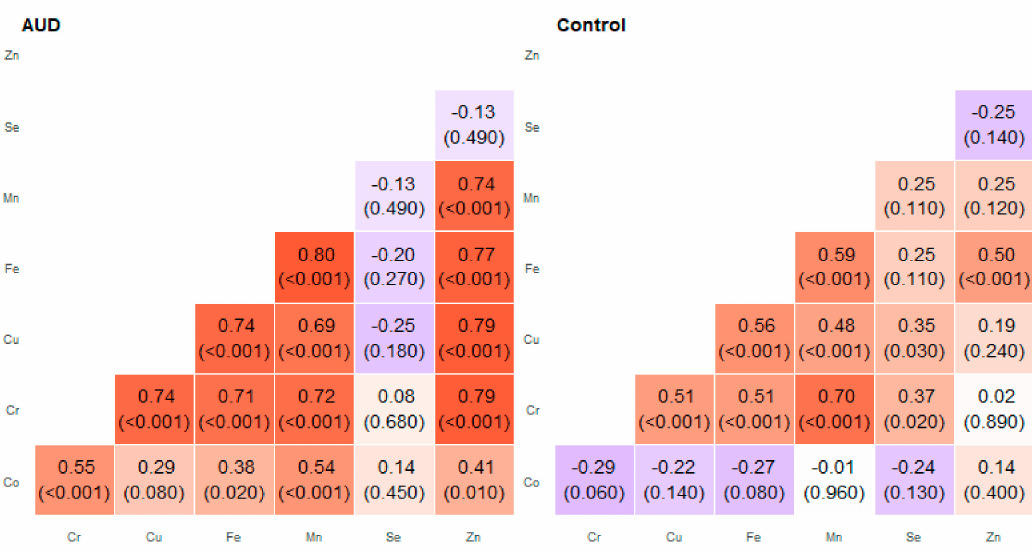
Figure 4. Correlation matrix of Spearman coe ffi cient charts in the frontal part of the thalamus region in the alcohol use disorder and control